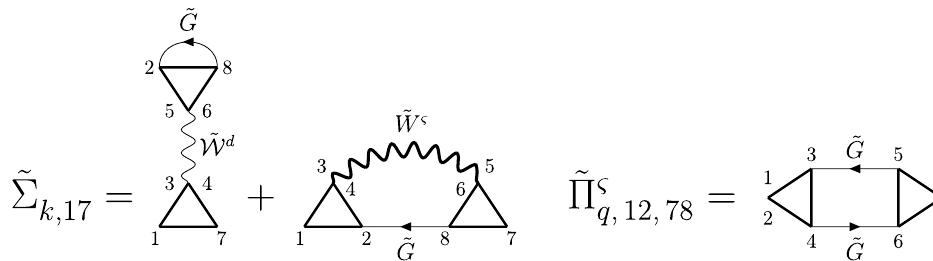
Figure 1: Diagrammatic representation for the dual self-energy ˜ Σ (left) and the dual polarization operator ˜ Π (right). The two processes contributing to ˜ Σ are expressed mathematically in Eqs. (17) and (18). The expression for ˜ Π is explicitly written in Eq. (19). Wavy lines represent dual bosonic propagators and straight lines depict dual Green’s function, as explicitly indicated in the Figure. Triangles represent three-point vertex functions Λ ς . Numbers correspond to band indices. The bosonic end of the νω triangle can be identified by the fact that it carries two band